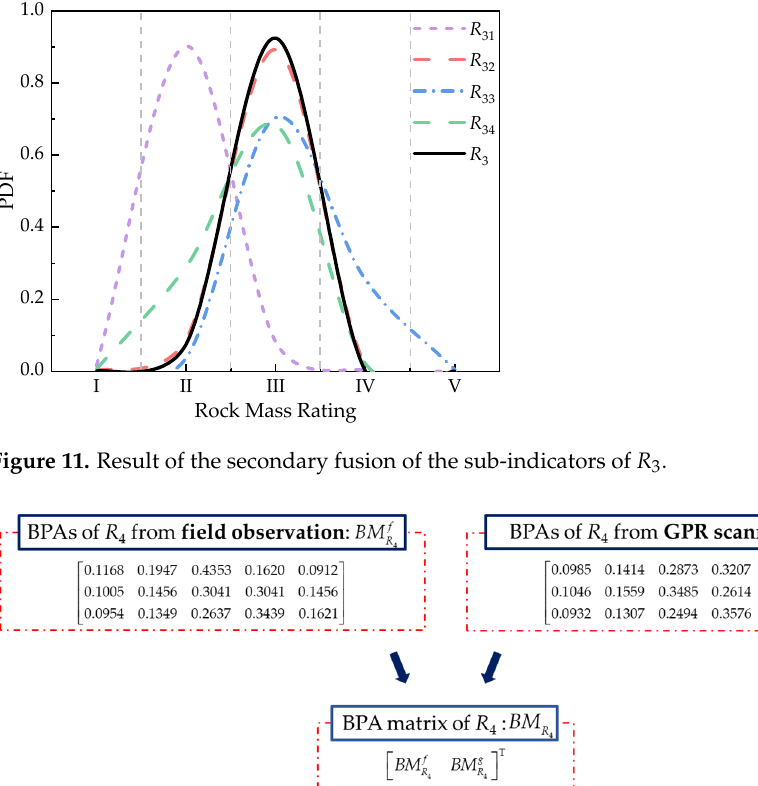
BM constructed with BPAs of R 3 . Figure 10. BM Figure 10. R 3 constructed with BPAs of R 3 . 3 R